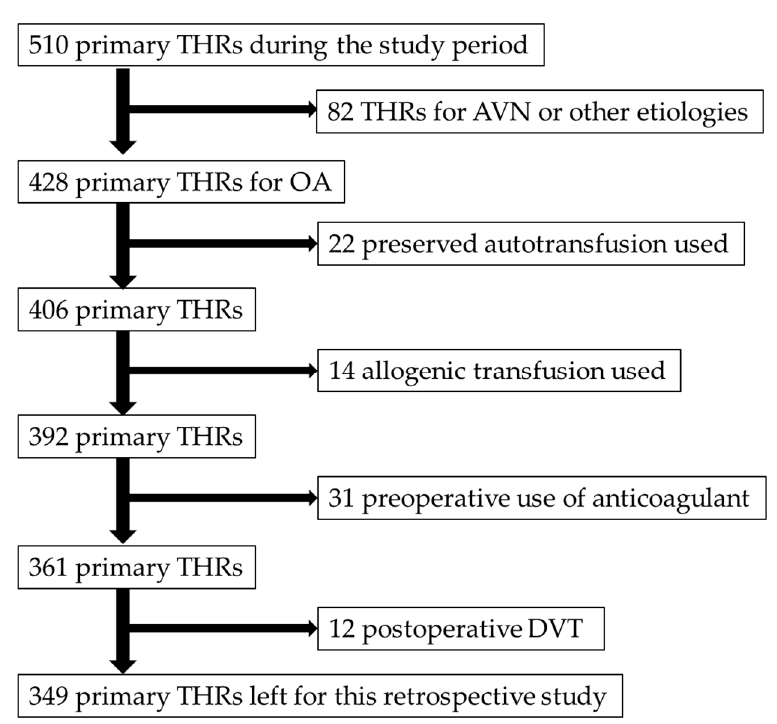
Figure 1. Patients inclusion and exclusion algorithm. THA: total hip arthroplasty, AVN: avascular necrosis, OA: osteoarthritis, DVT: deep vein thrombosis. Table 1. Demographics and blood test results for each